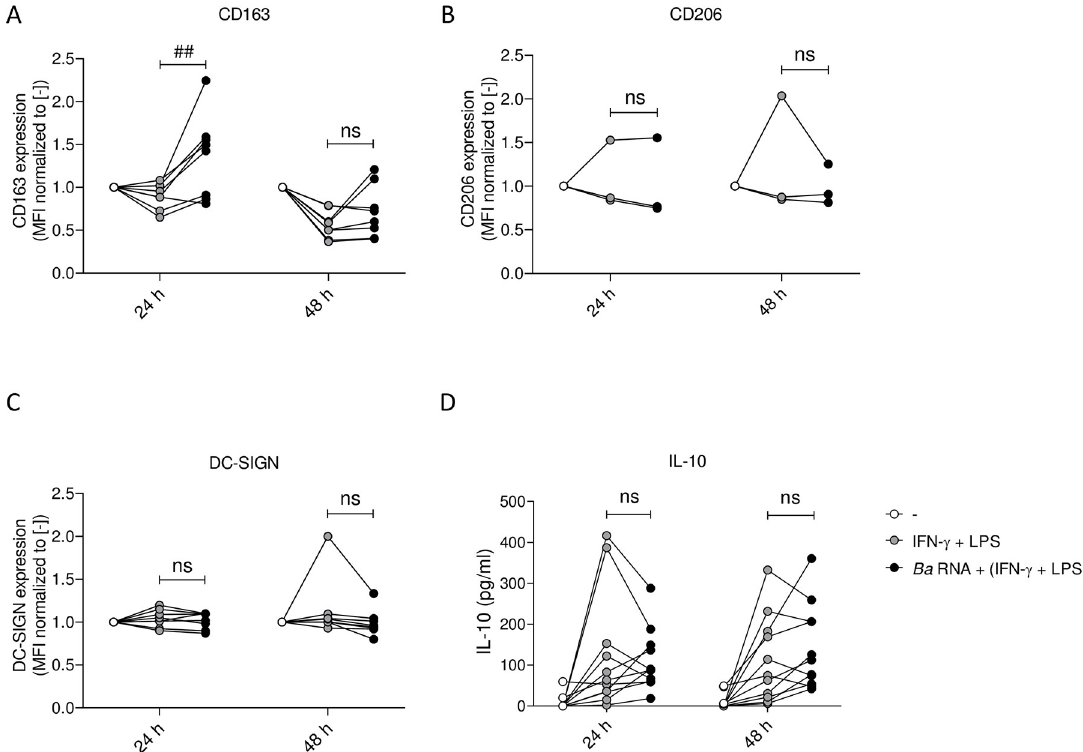
Fig 7. Ba RNA does not modulate the expression of M2 markers under M1 polarizing conditions. Human M0 macrophages were stimulated with Ba RNA for 24 and 48 h in the presence of IFN- γ + LPS. (A) CD163, (B) CD206 and (C) DC-SIGN (M2 markers) expressions were determined by flow cytometry. Dots indicate the geometric means normalized to untreated cells of at least three independent experiments. (D) Secretion of IL-10 was quantified by ELISA sandwich in supernatants. Dots indicate the geometric means of eleven independent experiments. Cells treated with IFN- γ and LPS were used as a positive control. MFI, mean fluorescence intensity ns, non-significant; ## P < 0.01 vs. cells treated with IFN- γ + LPS.